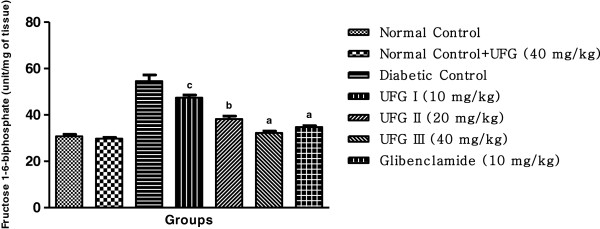
Effect of umbelliferone β-D-galactopyranoside on level of Fructose1-6-biphosphate at different concentrations on STZ induced diabetic rats, compared to diabetic control group rats; values are mean ± SEM; n = 6;
c
P < 0.05;
b
P < 0.01;
a
P < 0.001; P > 0.05 is considered as non-significant (ns).